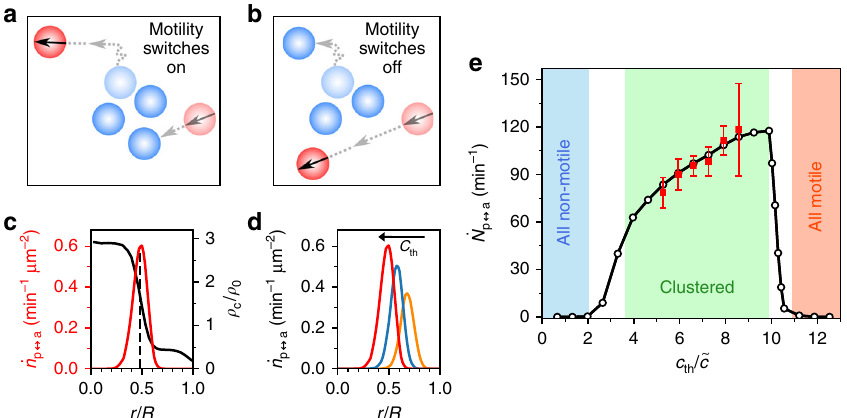
Fig. 4 Cluster formation by motility switching. a Schematic illustration of the in fl uence of motility switches. An active particle (red) is approaching a cluster of three passive particles (blue) and becomes passive which favours joining the cluster. On the opposite, a passive particle slightly diffusing away from a cluster becomes active which facilitates leaving it. b Same situation without motility changes. c Numerically obtained radial density pro fi le ρ ( r ) and motility ð r Þ for λ = 10 σ and a concentration threshold c = 8.6 ~ c . Motility changes are localised at the interfacial region, the centre of the change density _ n th p $ a ð r Þ . d Motility change density _ n ð r Þ at λ = 10 σ and c = [5.9,7.3,8.6] ~ c . With increasing c interface (dashed line) coincides with the maximum of _ n th th , p $ a p $ a the distribution increases in height and is shifted to smaller r (as the cluster size decreases). e Total rate of motility changes _ N versus c th for λ = 10 σ p $ a from simulations (open) and experiments (closed symbols). Error bars correspond to the standard deviation of different measurements